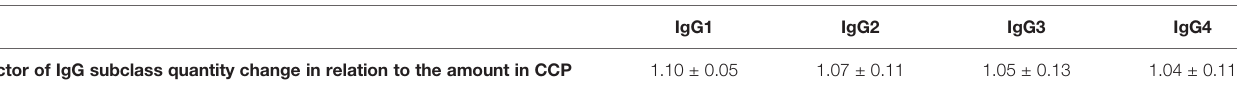
TABLE 5 | Final product ’ s IgG subclass